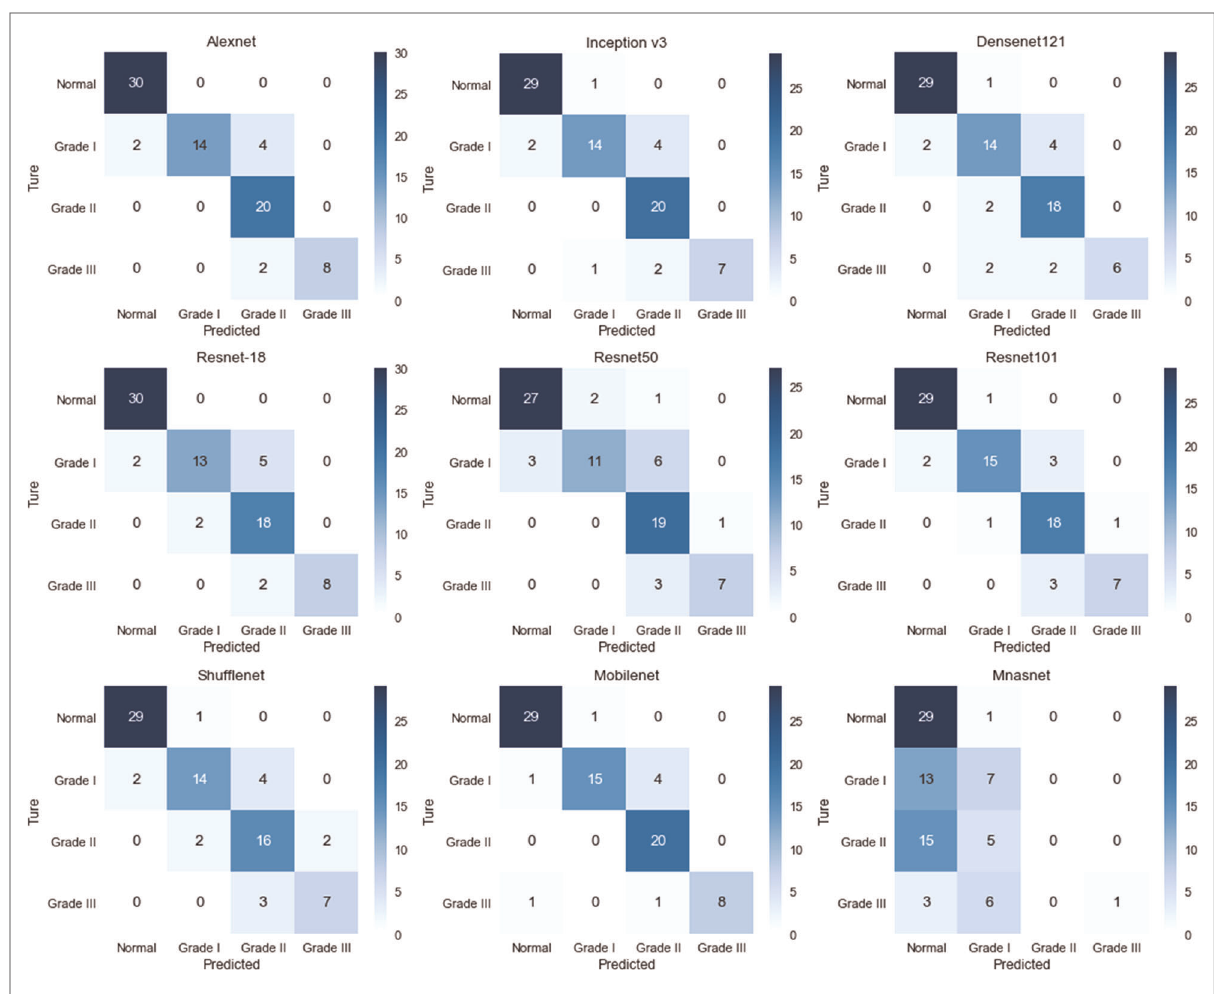
FIGURE 3 The confusion matrix of the convolutional neural networks for assessing the severity of microtia.